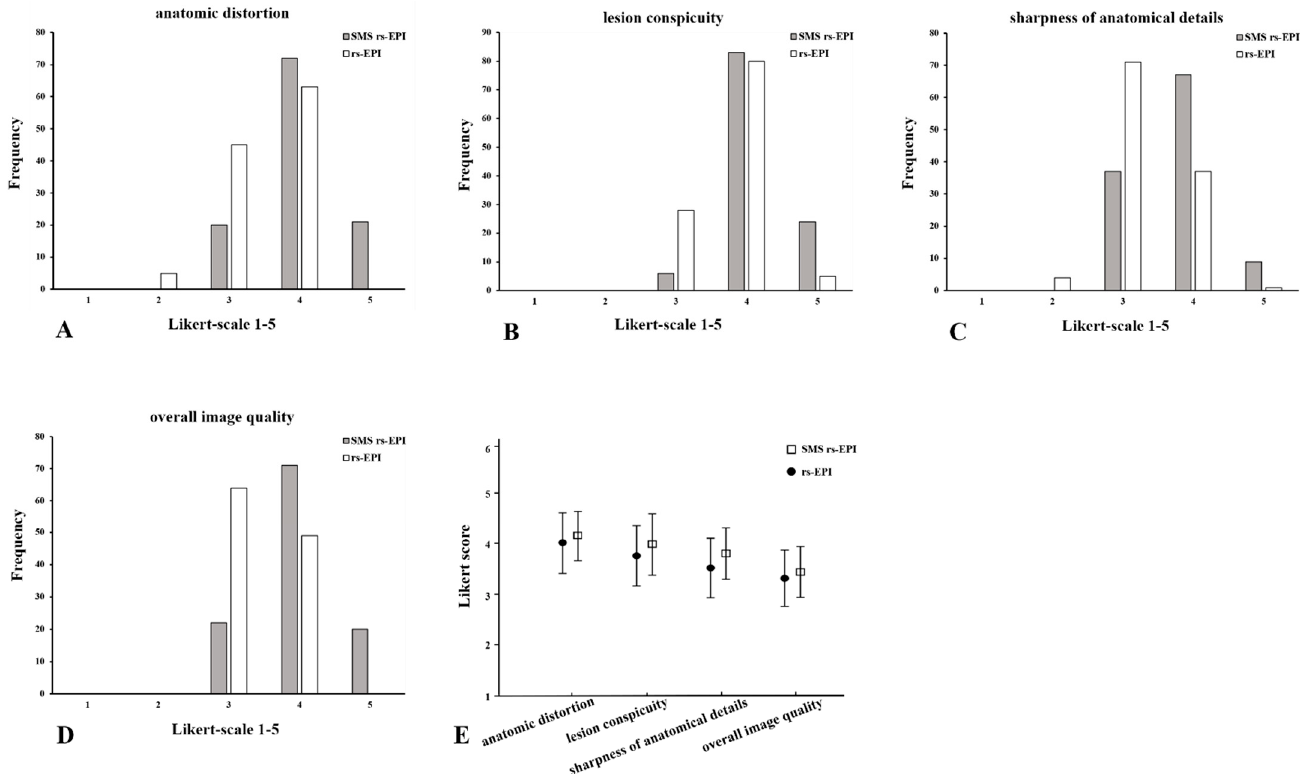
Figure 2. Histogram of the evaluation of image quality: anatomic distortion ( A ), lesion conspicuity ( B ), sharpness of anatomical details ( C ) and overall image quality ( D ) using Likert scoring; mean values and standard deviation of quality scores ( E ). Comparison of SMS rs-EPI sequence and rs-EPI sequence.